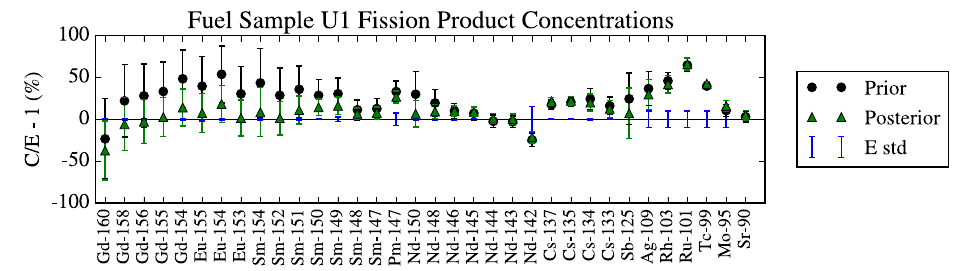
Figure 2. Prior and posterior biases and uncertainties of the simulated fission product concentrations of fuel sample U1.